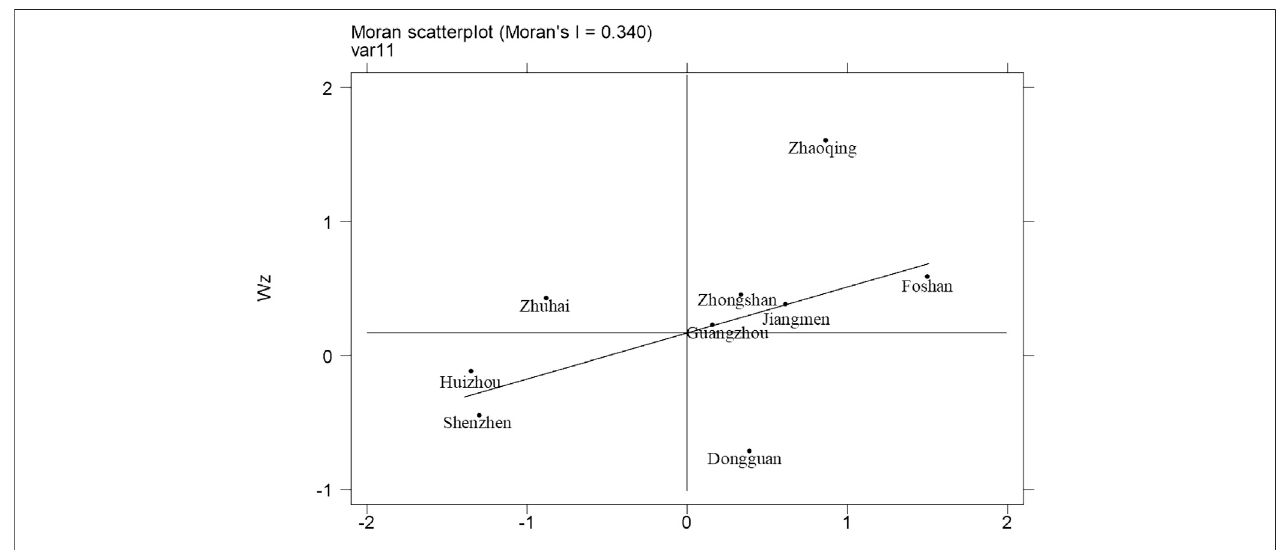
FIGURE 7 | Moran scatter plot of PM 2.5 in the Pearl River Delta region in 2010.